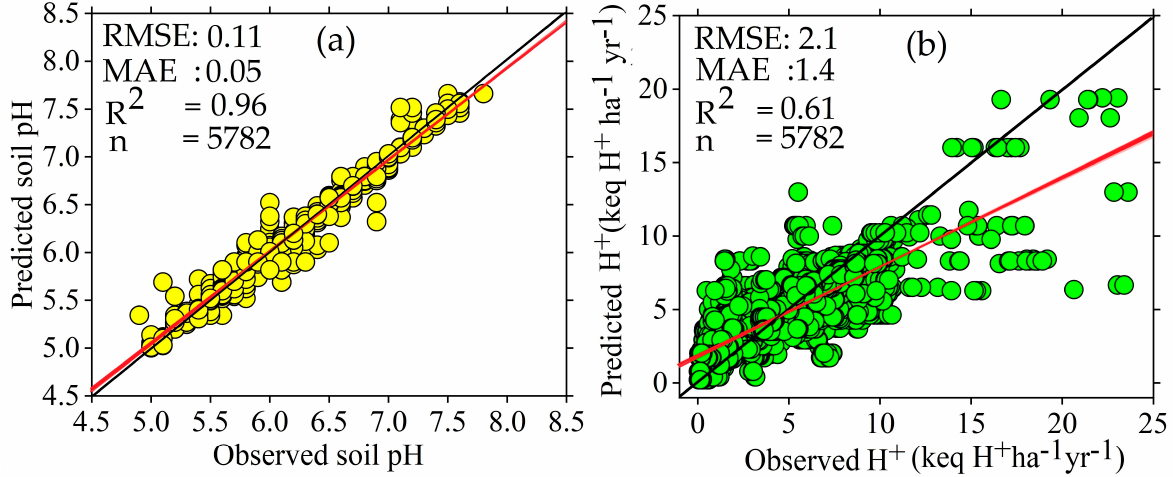
Figure 4. Model performance evaluation of soil pH and soil acidification: soil pH model performance ( a ) and soil acidification model performance ( b ), RMSE: root mean squared errors, MAE: mean absolute errors, R 2 : coefficient of determination and n: number of field trials, the red line is the prediction line and the black line is the 1:1 line.